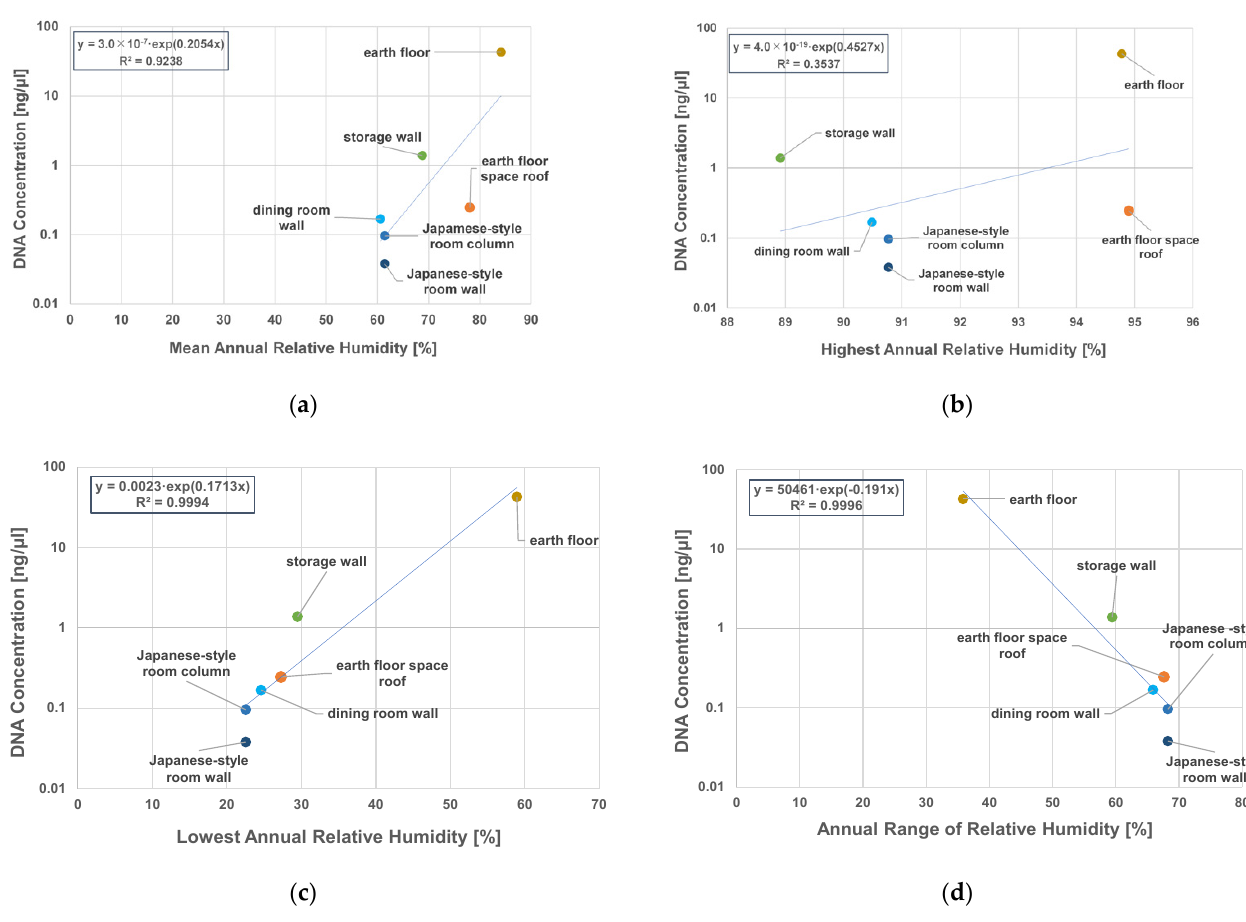
Figure 6. Correlation between DNA concentrations of microorganisms and relative humidity on indoor surfaces. The horizontal axis represents the ( a ) mean annual relative humidity, ( b ) highest annual relative humidity, ( c ) lowest annual relative humidity, and ( d ) annual range of relative humidity.